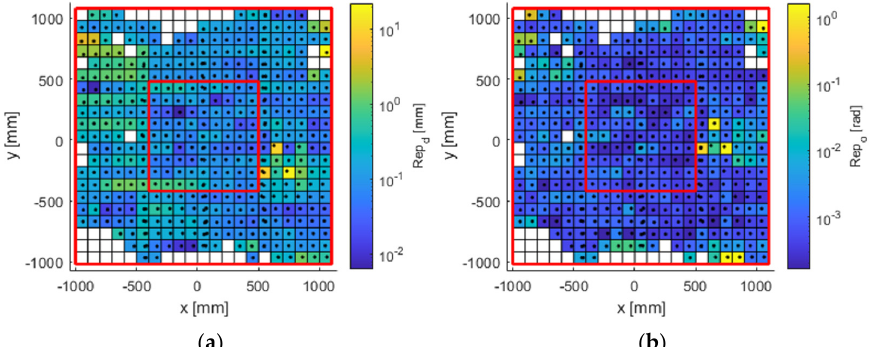
Figure 12. Spatial repeatability error in ( a ) position (mm); and ( b ) orientation (rad). The available work area. The red lines delimit the large and inner areas.